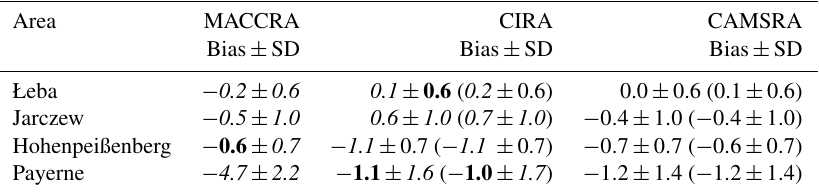
Table 7. Monthly mean surface NO 2 biases and standard deviations from MACCRA, CIRA and CAMSRA relative to GAW surface NO 2 data (shown in Fig. 19; in ppb). The values are calculated for the period 2003–2012, and the values in brackets are calculated for CIRA and CAMSRA for the period 2003–2016. Numbers in italics mark where MACCRA or CIRA have larger biases or standard deviation than CAMSRA, and numbers in bold mark where their values are smaller.